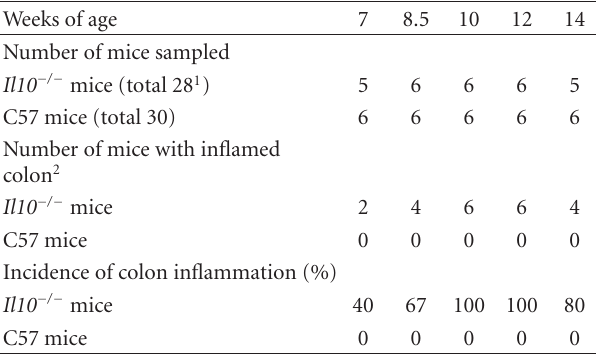
Table 2: Time of onset and incidence of colon inflammation in Il10 − / −